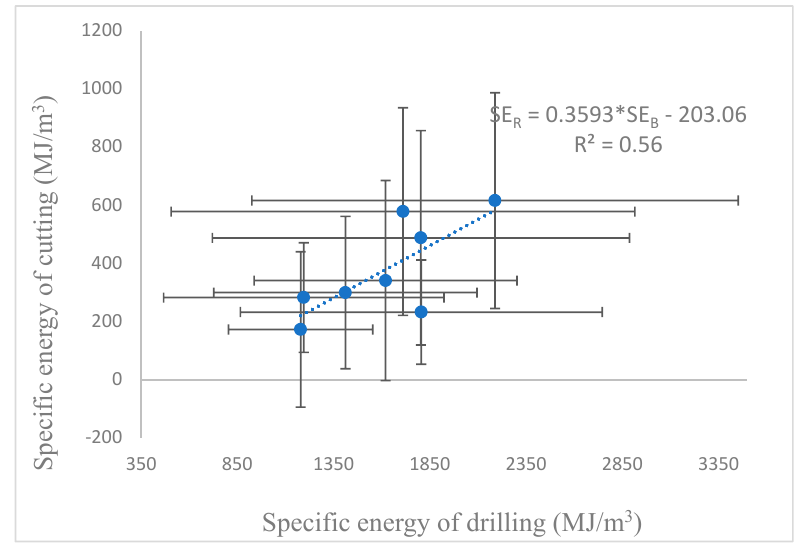
Figure 7. Diagram of the dependence of the specific rock cutting energy on the specific drilling en- ergy (electrical power measuring system) by groups.